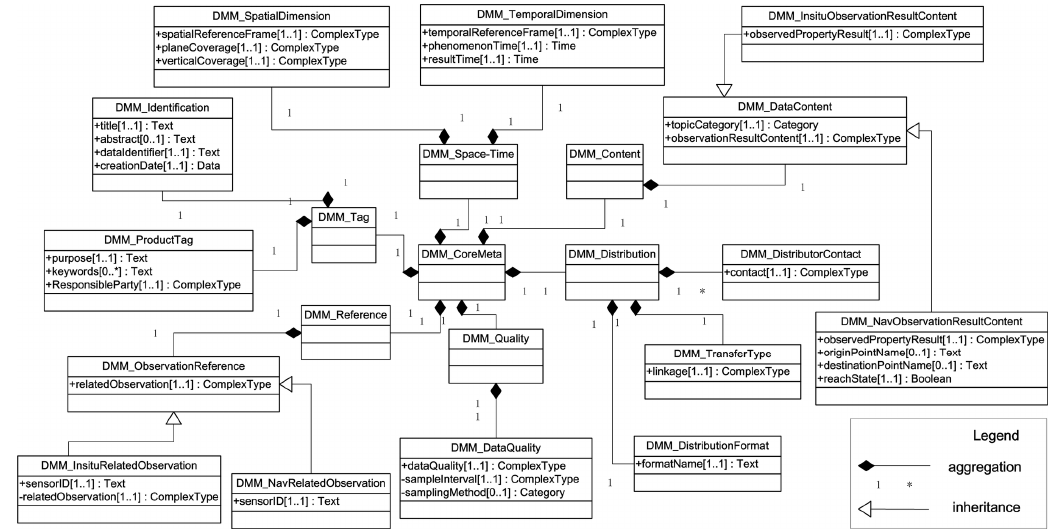
Figure 4. Unified Modeling Language (UML) diagram of the Data Meta-Model (DMM) for interdisciplinary instant point observations sharing.